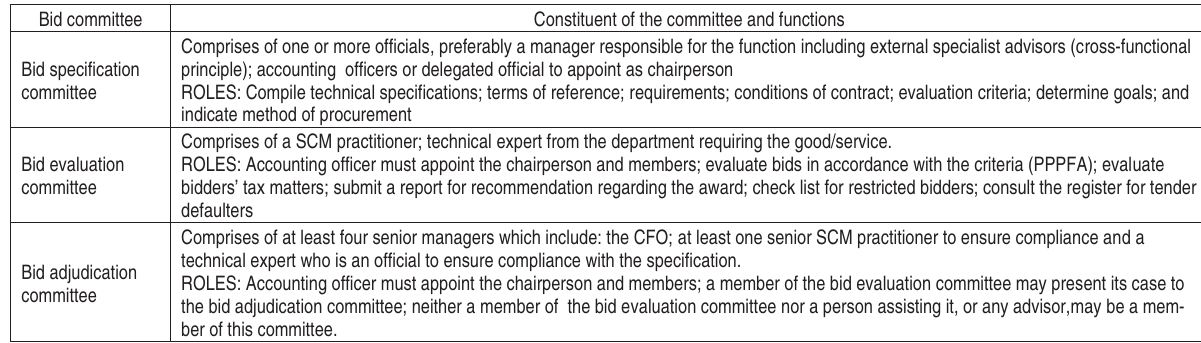
Table 2. Bid committees, constituent and